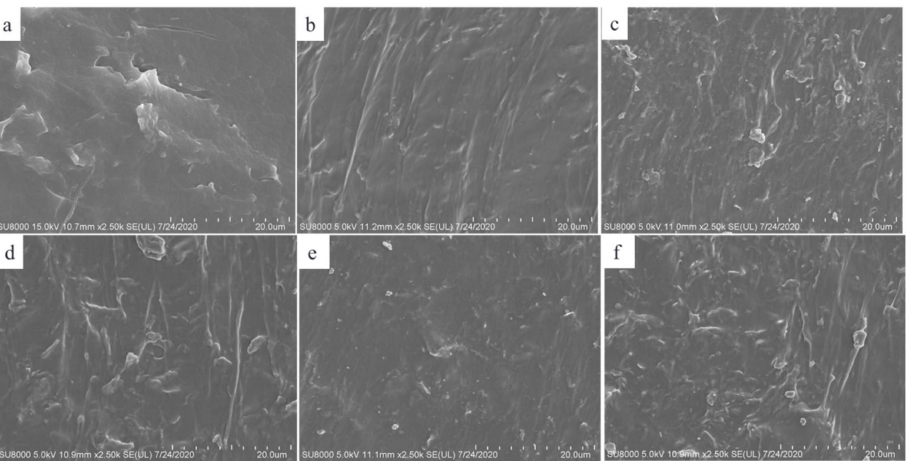
Figure 2. SEM images of the cross-section morphology of the composite films with TPU initial concentrations of 20 wt% loading of graphene of 3 wt% ( a ), 4 wt% ( b ), 5 wt% ( c ), 7 wt% ( d ) and TPU initial concentrations of 10 wt% ( e ) 30 wt% ( f ) and 4 wt% graphene, respectively.